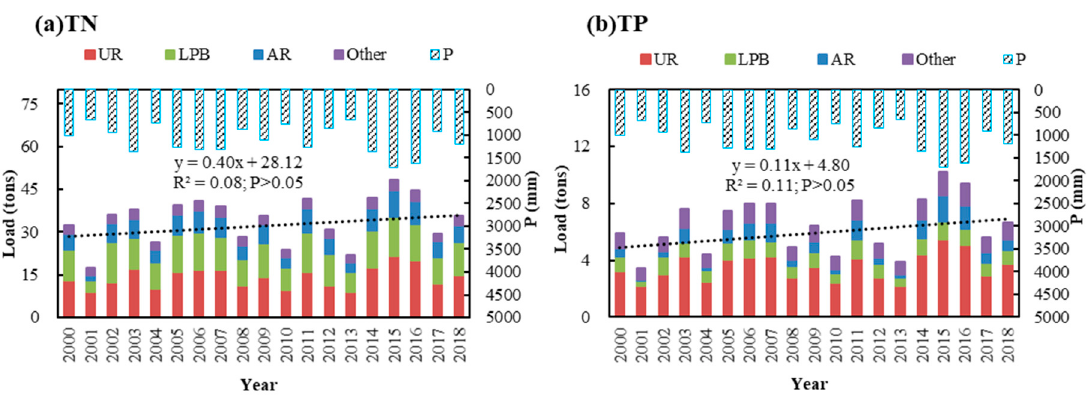
Figure 12. Interannual pollution emissions of each source (UR, LPB, AR and other) into rivers.